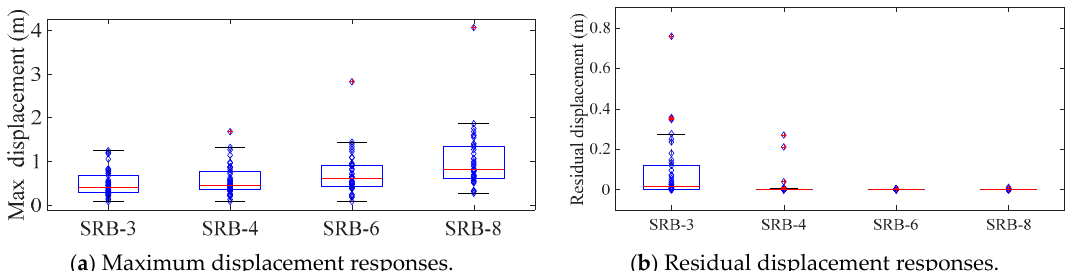
Figure 6. Comparisons of displacement control performances of different SRB models subjected to ground motions of Group 2.